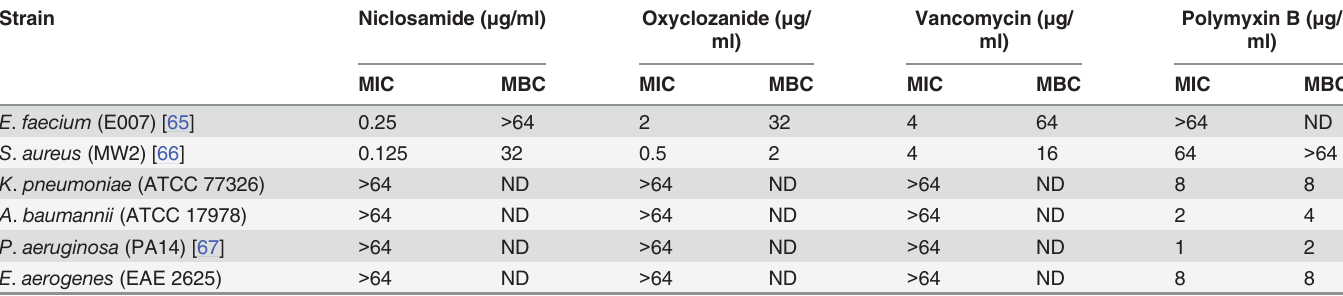
Table 1. Comparative antibacterial activities of niclosamide, oxyclozanide, vancomycin and polymyxin B against ESKAPE pathogens.